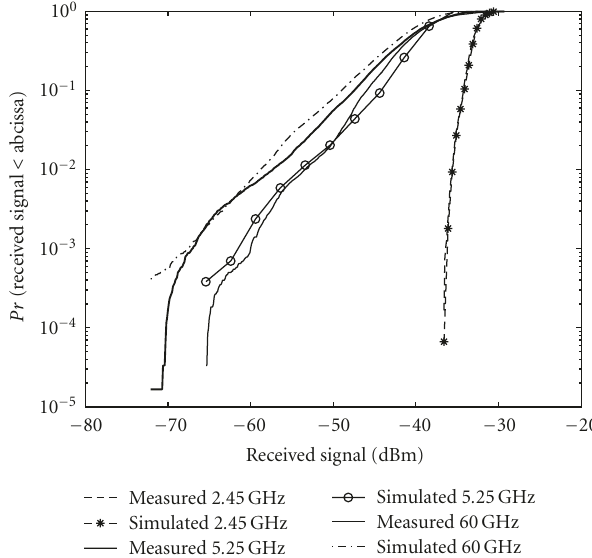
Figure 15: CDFs of measured (dry leaved deciduous trees (Site 1)) and simulated (using the new model) signals at 2.45, 5.25, and 60GHz during high ( w m = 5 m/s) wind speed conditions. All simulation parameters are given in Table